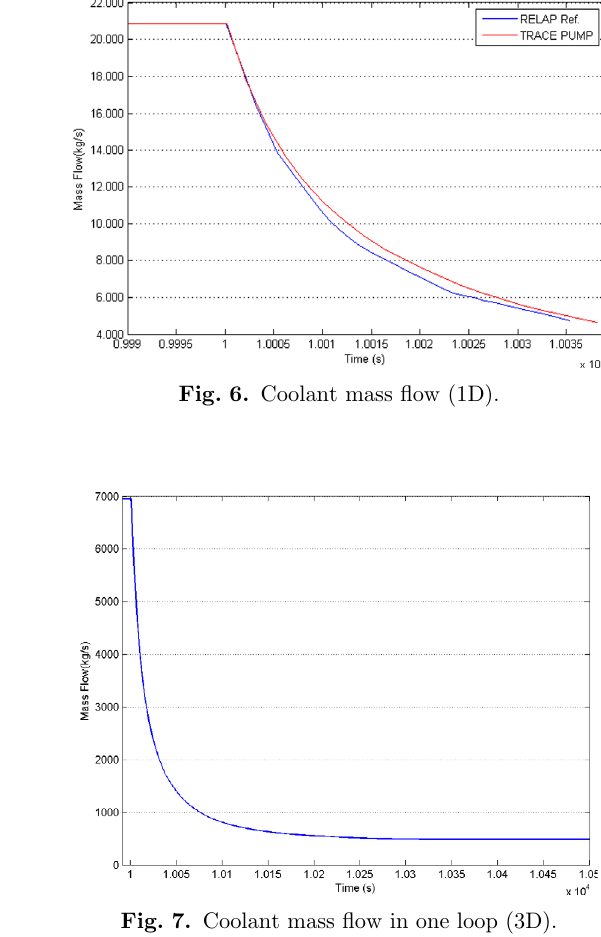
Table 5. Steady-state results (1D).